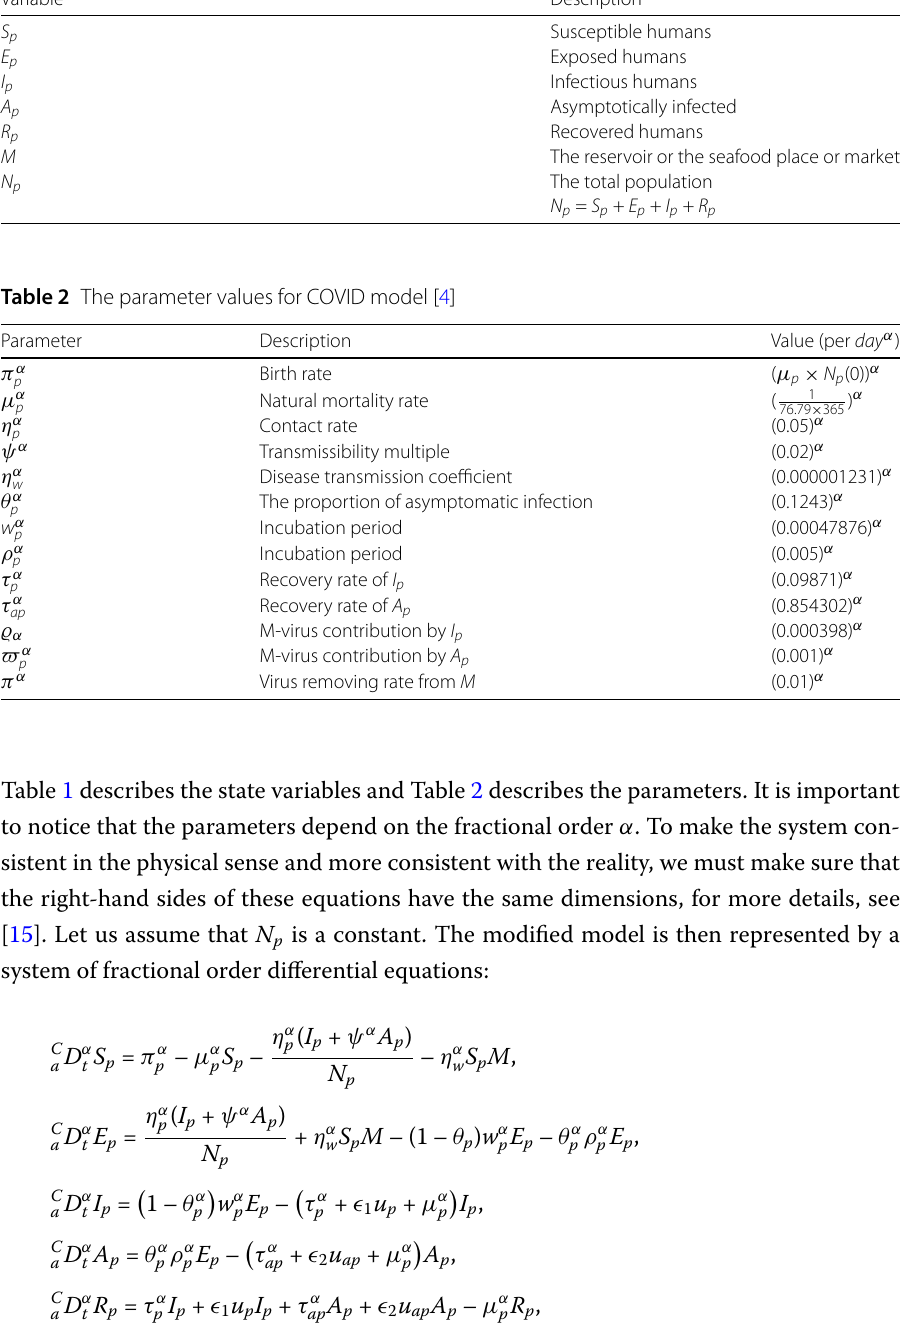
Table 1 The variables of system (2) [4] Variable